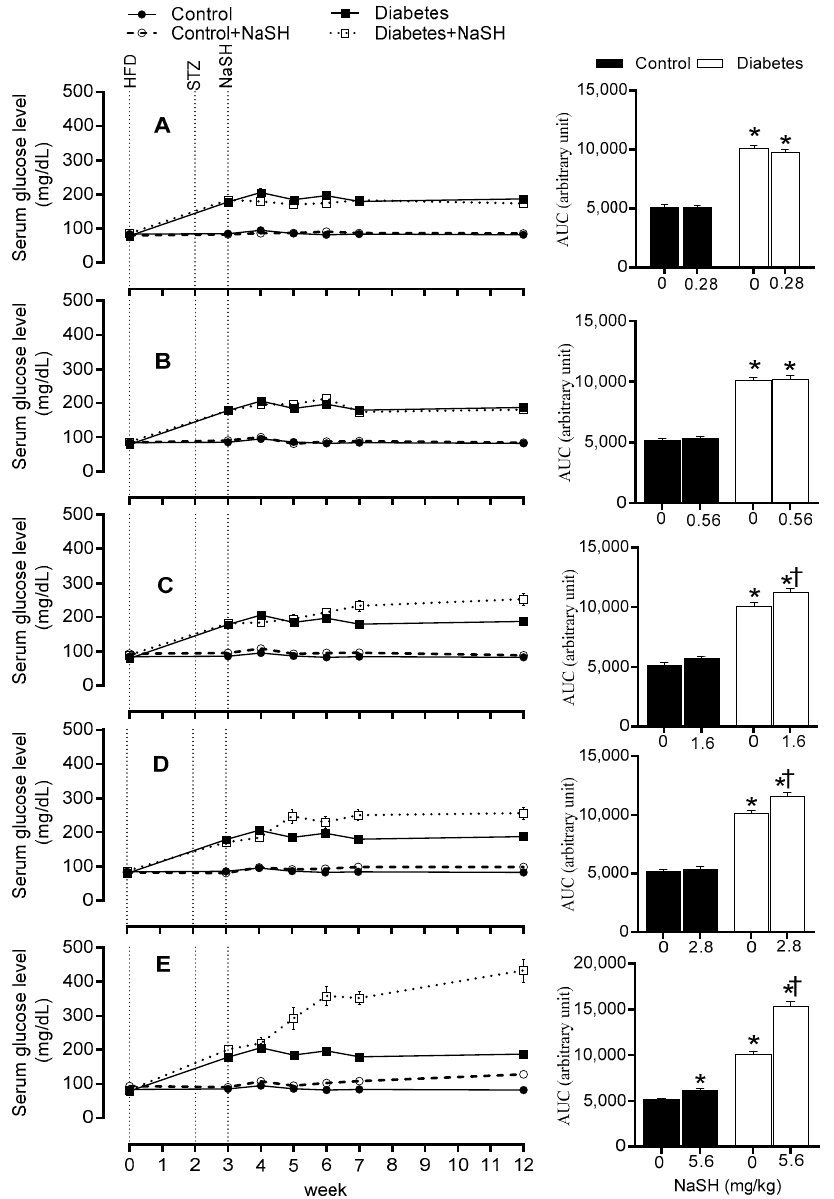
Figure 3. Effects of NaSH at 0.28 ( A ), 0.56 ( B ), 1.6 ( C ), 2.8 ( D ), and 5.6 ( E ) mg/kg on serum glucose concentrations. Area under the curves (from week 3 to week 12) are shown in columns on the right. Results are mean ± SEM (n = 10/group). * p < 0.05 compared to non-treated control rats, † p < 0.05 compared to non-treated diabetic rats.